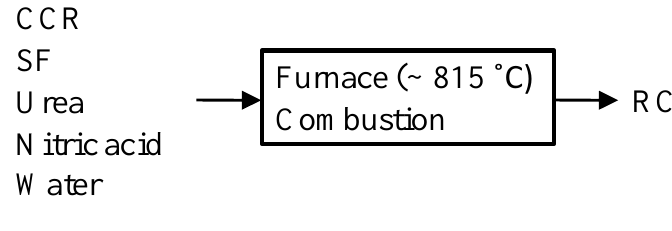
Figure 1. Flow chart of the RCP synthesis process. Table 4. Mixing proportions for synthesizing RCP.